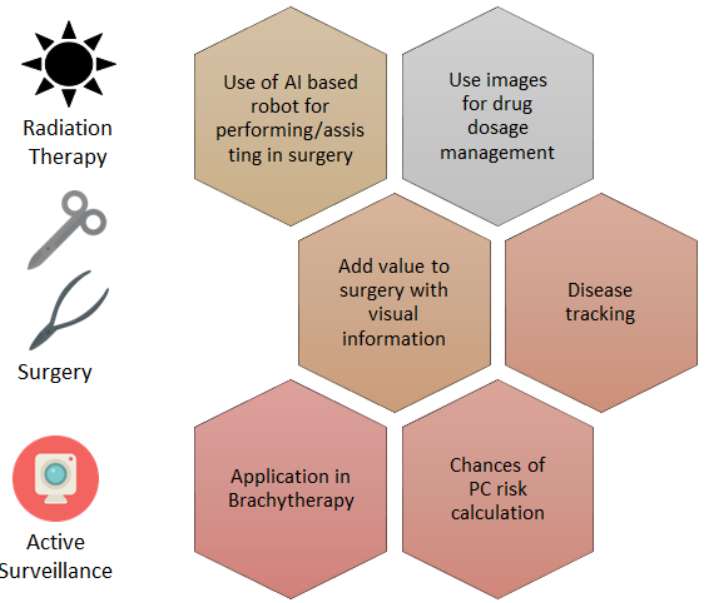
Figure 7. Summary of AI direct application and assistance in PC treatment.